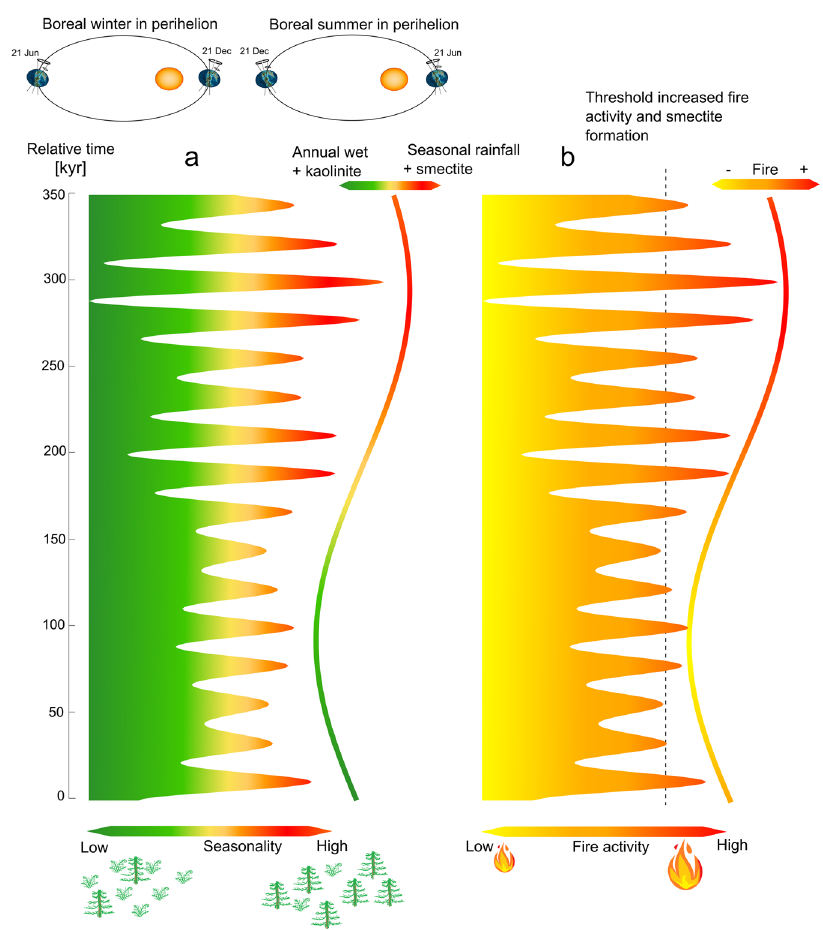
Fig. 3 Schematic model of eccentricity modulated, precession driven changes in seasonality and wild fi re over the studied interval. a Magnitude changes in seasonality are plotted on the x-axis over relative time (kyr) on the y-axis. One precession cycle contains ~10 kyr of relatively high seasonality (red) and ~10 kyr of relatively weaker seasonality (green) (for the Northern Hemisphere). Strongest seasonality is found during maximal precessional forcing (hemisphere speci fi c summer coinciding with perihelion), coinciding with maximum 405 kyr eccentricity. The 405 kyr eccentricity modulation is schematically drawn in the green to red curve, with higher amounts of kaolinite indicating a year-round wet season and an acceleration of the hydrological cycle, whereas enhanced amounts of smectite indicate the presence of a dry and wet season (monsoonal climate). Coupled to a change in the hydrological cycle, we hypothesize that vegetation shifted from humidity loving species to fl ora that thrived in a seasonally dry climate. b Magnitude changes in wild fi re activity are plotted on the x-axis and relative time (kyr) on the y-axis, with low fi re activity on the left (yellow) to high fi re activity on the right (red). Coeval with changes in seasonality, fi re activity changes over each precession cycle, which contains ~10 kyr of relatively high wild fi re activity (and seasonality) and ~10 kyr of relatively low wild fi re activity (and seasonality). Next to this, wild fi re activity is in fl uenced by the 405 kyr modulation. The dashed black line indicates a fi re threshold, after which the seasonal contrast is likely extreme enough to lead to enhanced charcoal and smectite in the fossil